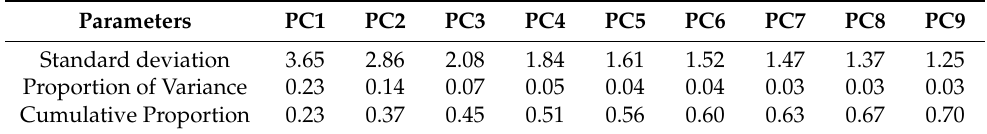
Table 4. Bottom teams’ principal components and total variance explained.